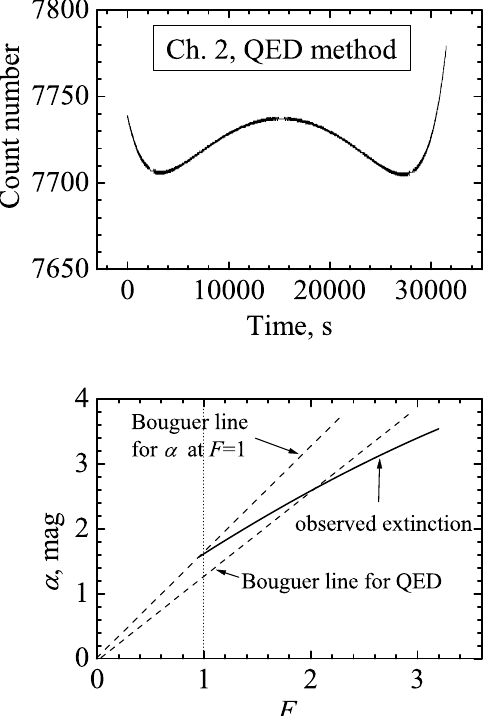
Fig. 8. Explanation, why we get the curved reduced observations after the Bouguer extinction correction with the QED program: the upper panel shows the observations reduced by the standard QED extinction correction procedure (Case I), the lower panel explains the cause of the wrong